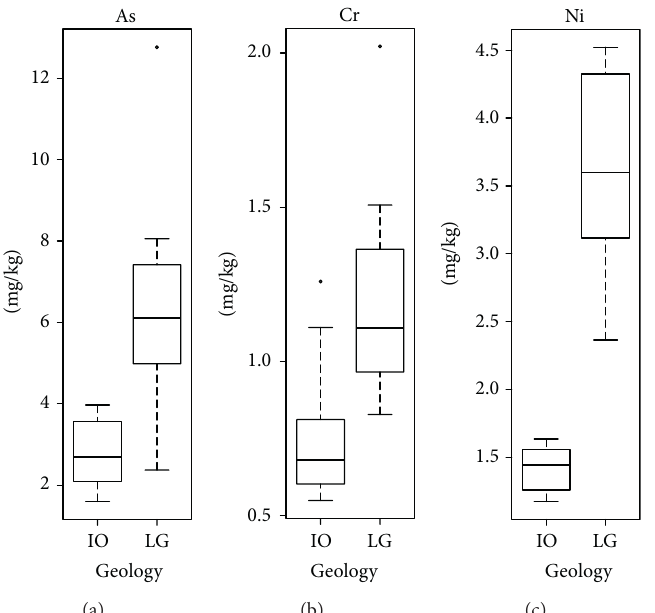
Figure 4: Box and Whisker plots for bioaccessible As, Cr, and Ni stratified by geology; “IO” represents the Inferior Oolite Group and “LG” represents the Lias Group. The bar shows the median value.